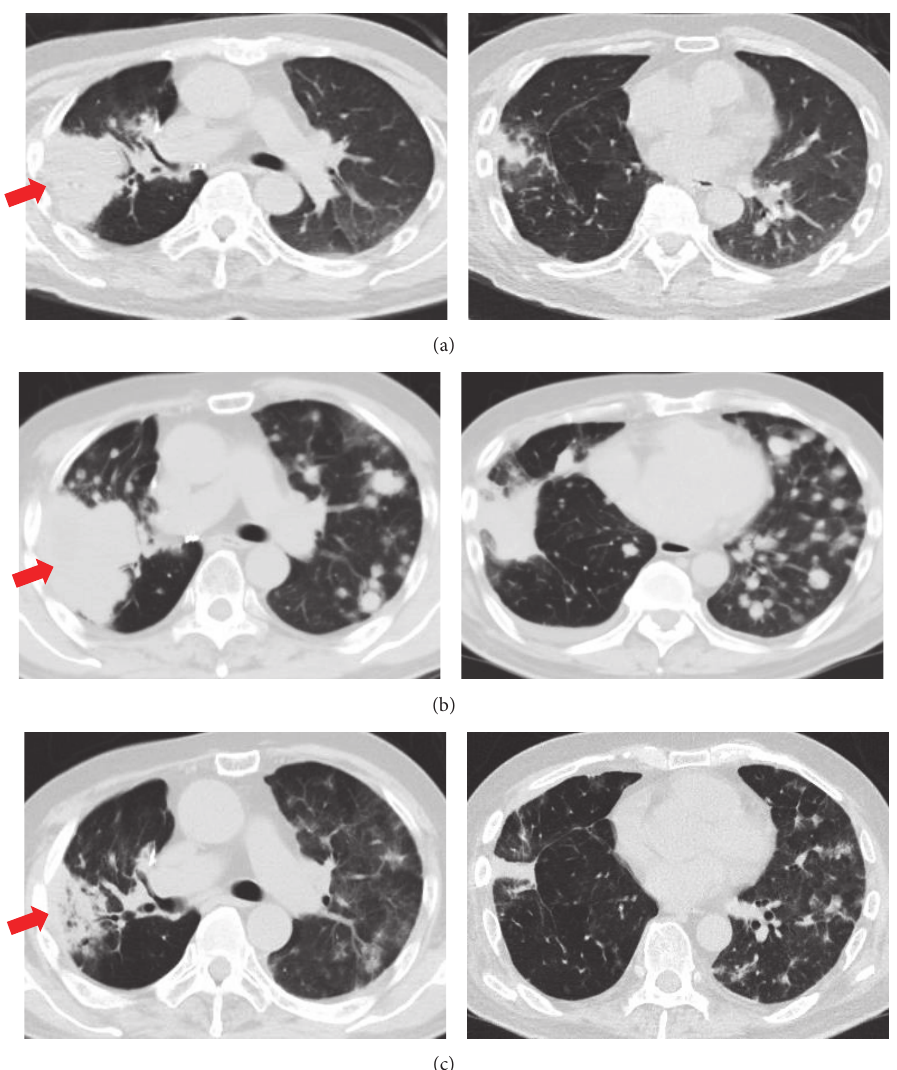
Figure 1: CT scan of the chest (a) before nivolumab treatment, (b) after 3 cycles of nivolumab treatment, and (c) osimertinib day 14.